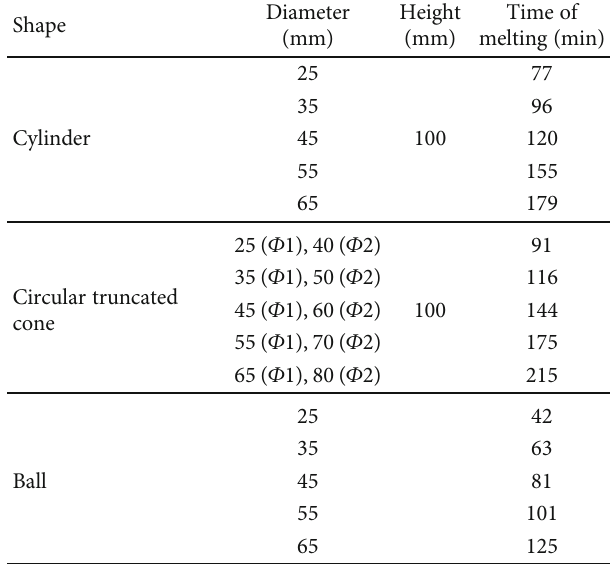
Table 1: The melting time for three kinds of shapes. Shape